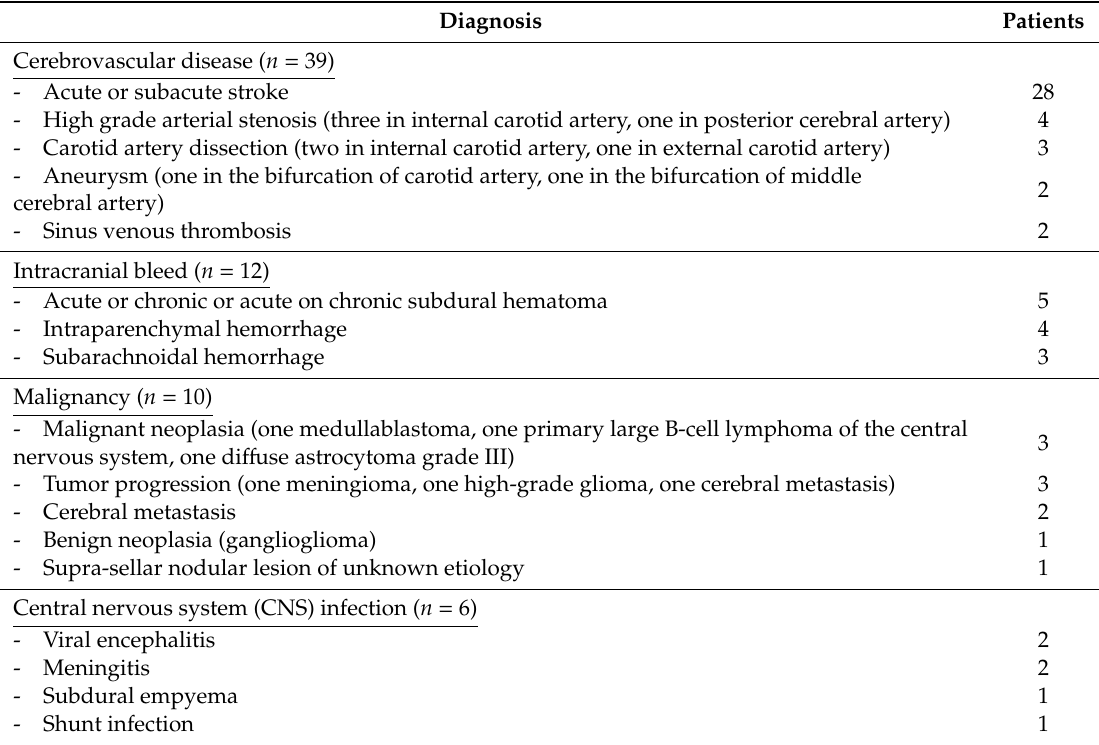
Table 2. Patients with significant intracranial abnormalities on computed tomography (CT) / magnetic resonance imaging (MRI)